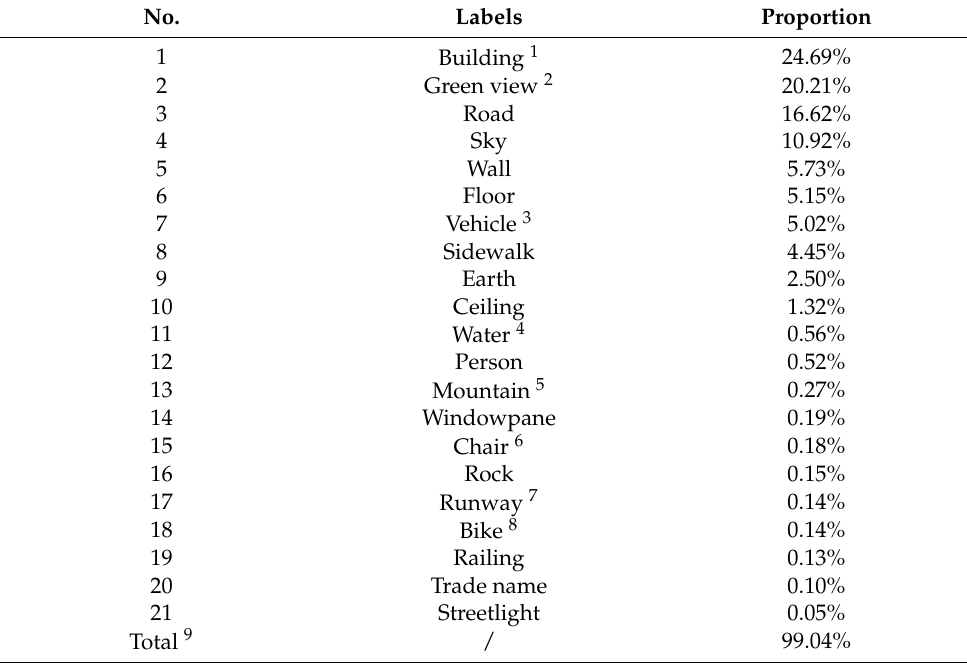
Table 2. Pixel Ratio of 21 Labels in All